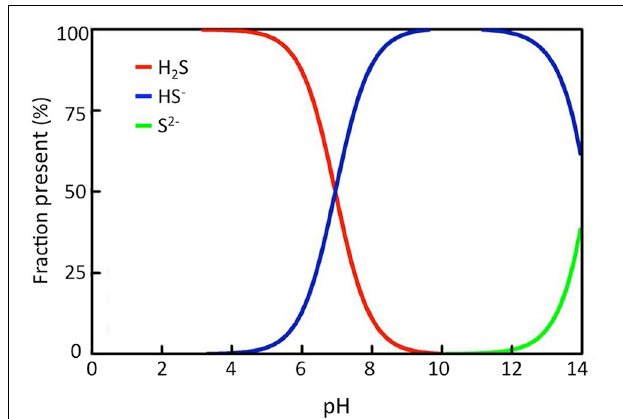
FIGURE 2 | Sulfide solubility chart showing the relative fraction of each sulfide species at different pH; H 2 S = hydrogen sulfide, HS − = hydrosulfide, S 2 − = sulfide